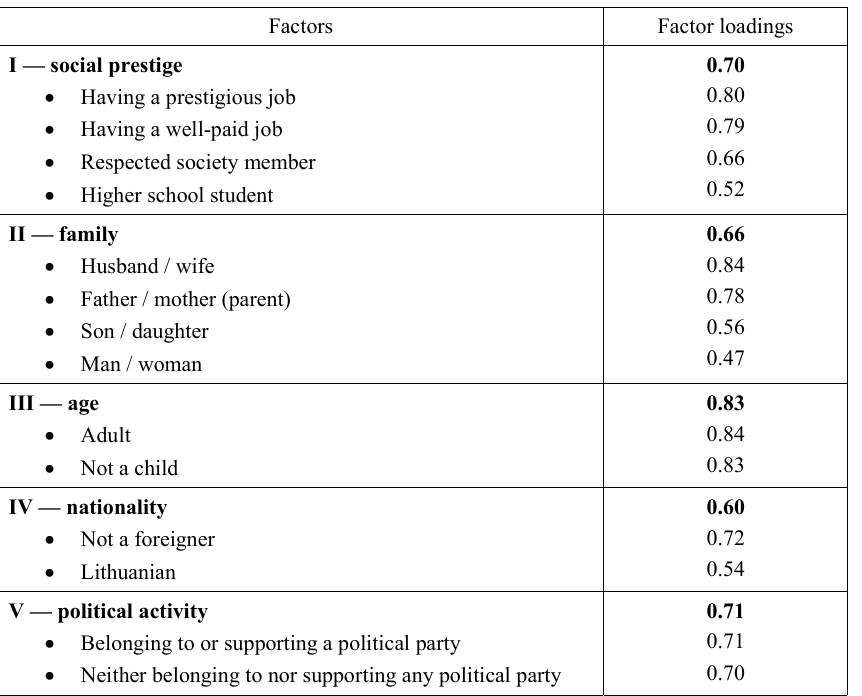
Table 2. Social identifications of would-be physical education